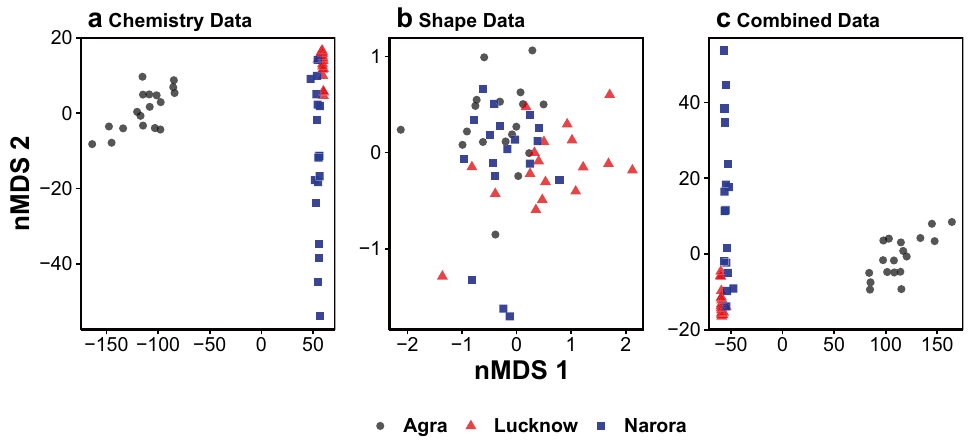
Figure 4. Distance based nMDS ordination based upon ( a ) the otolith chemistry dataset, ( b ) the otolith shape dataset, and ( c ) the combined otolith chemistry and shape dataset. Colours and shapes represent the three groups of C. striata . Dissimilarity matrix was based upon Euclidean distances. The assumption of homogeneity of variance was only satisfied for ( b ) Shape Data which would result in the results potentially being unreliable in ( a ) and ( c ).